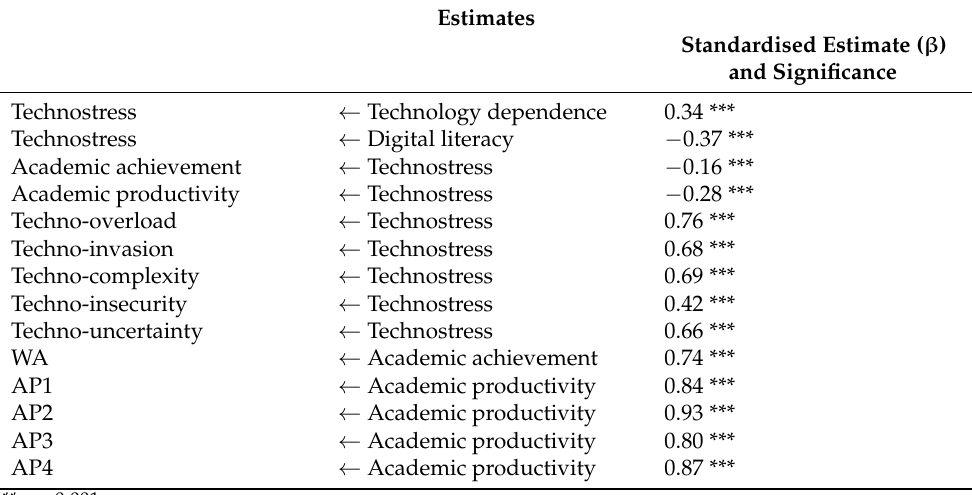
Table 10. Analysis of structural equation modelling